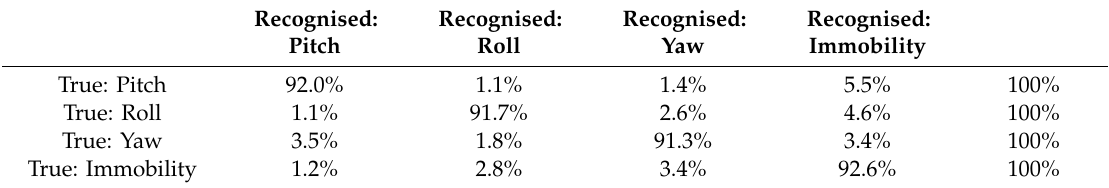
Table 3. The confusion matrix showing inter-gesture recognition errors for the SVM classifier with a 3rd degree polynomial and C = 1.0 (the classifier trained on parametrised IMU signals).